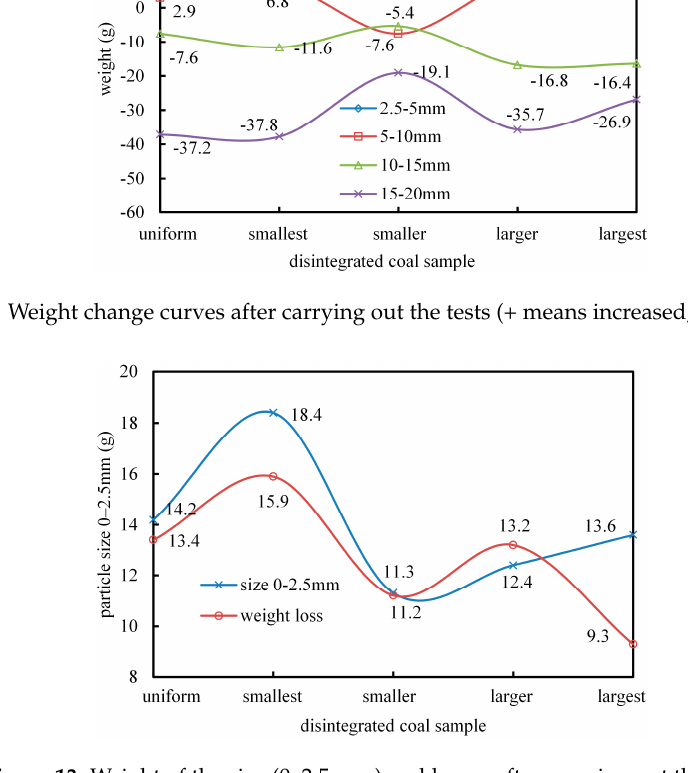
Figure 13. Weight of the size (0–2.5 mm) and losses after carrying out the tests.